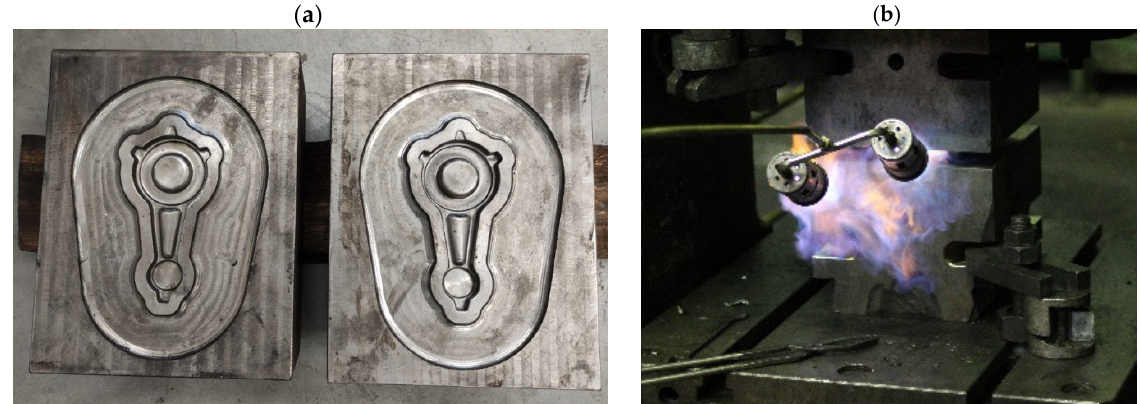
Figure 11. ( a ) Dies used for tests with finishing impressions ( b ) and the method of maintaining die temperature using gas burners.